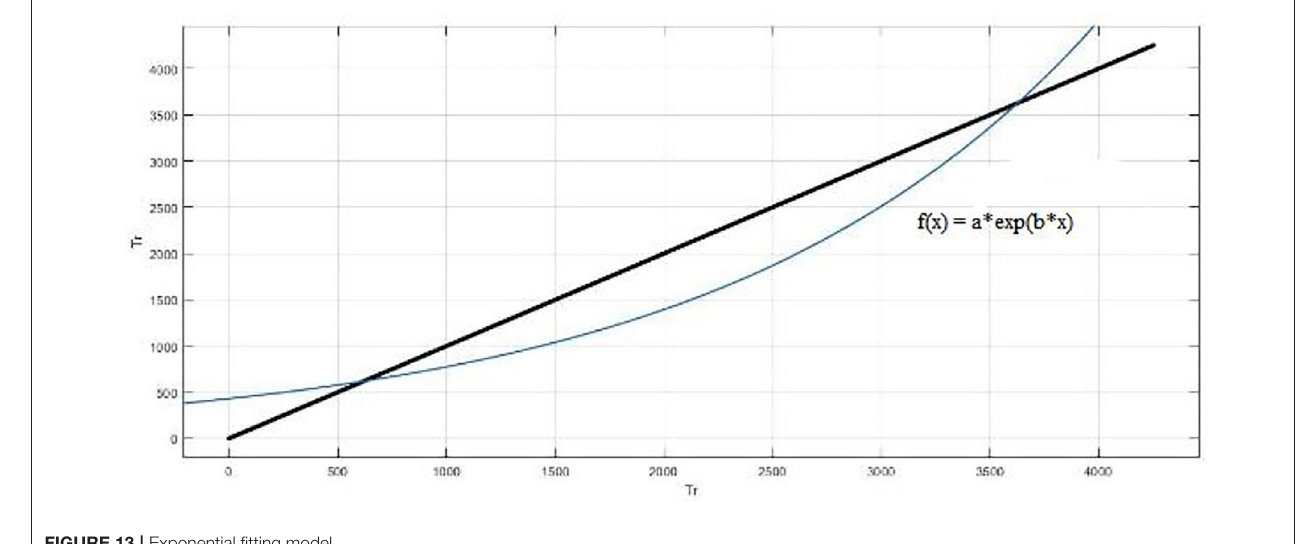
FIGURE 13 | Exponential fitting model.